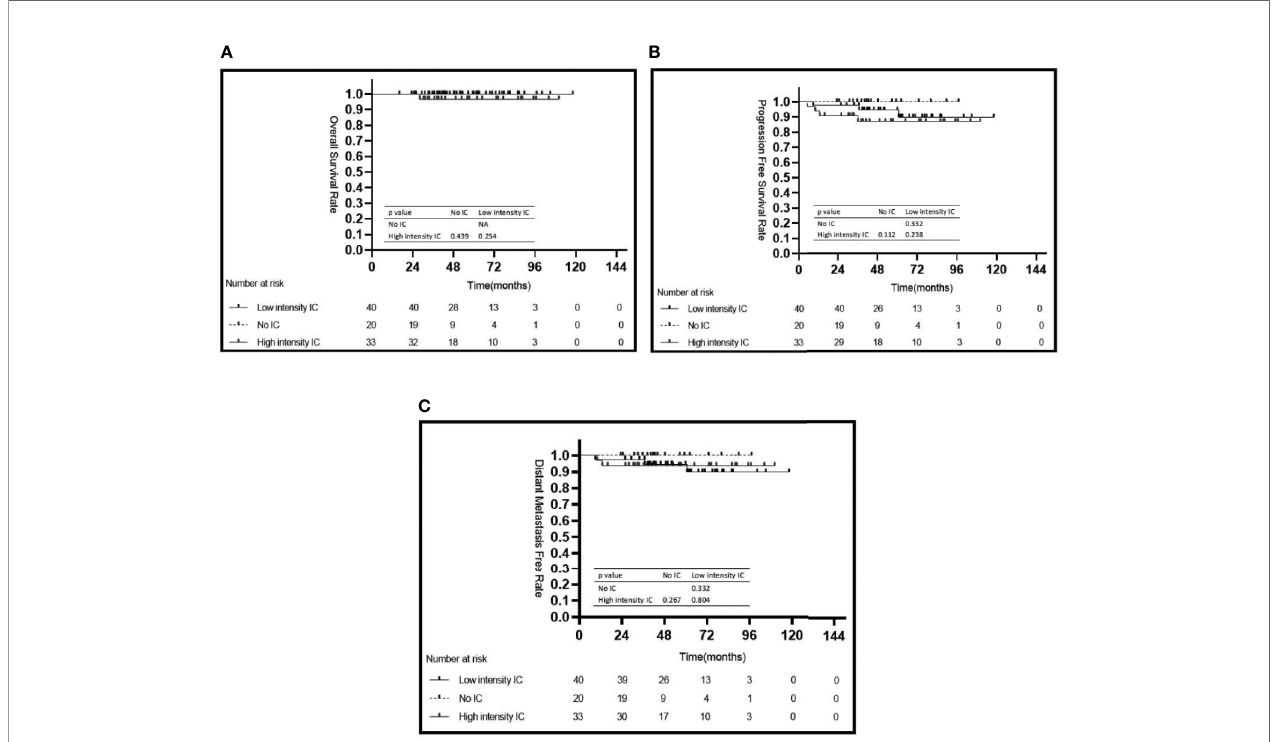
FIGURE 4 | Kaplan – Meier ’ s survivalcurvesforthesubgroupof93patients withNPCinthelow riskgroupstrati fi edbyintensityofinductionchemotherapy (A – C) .IC, induction chemotherapy.